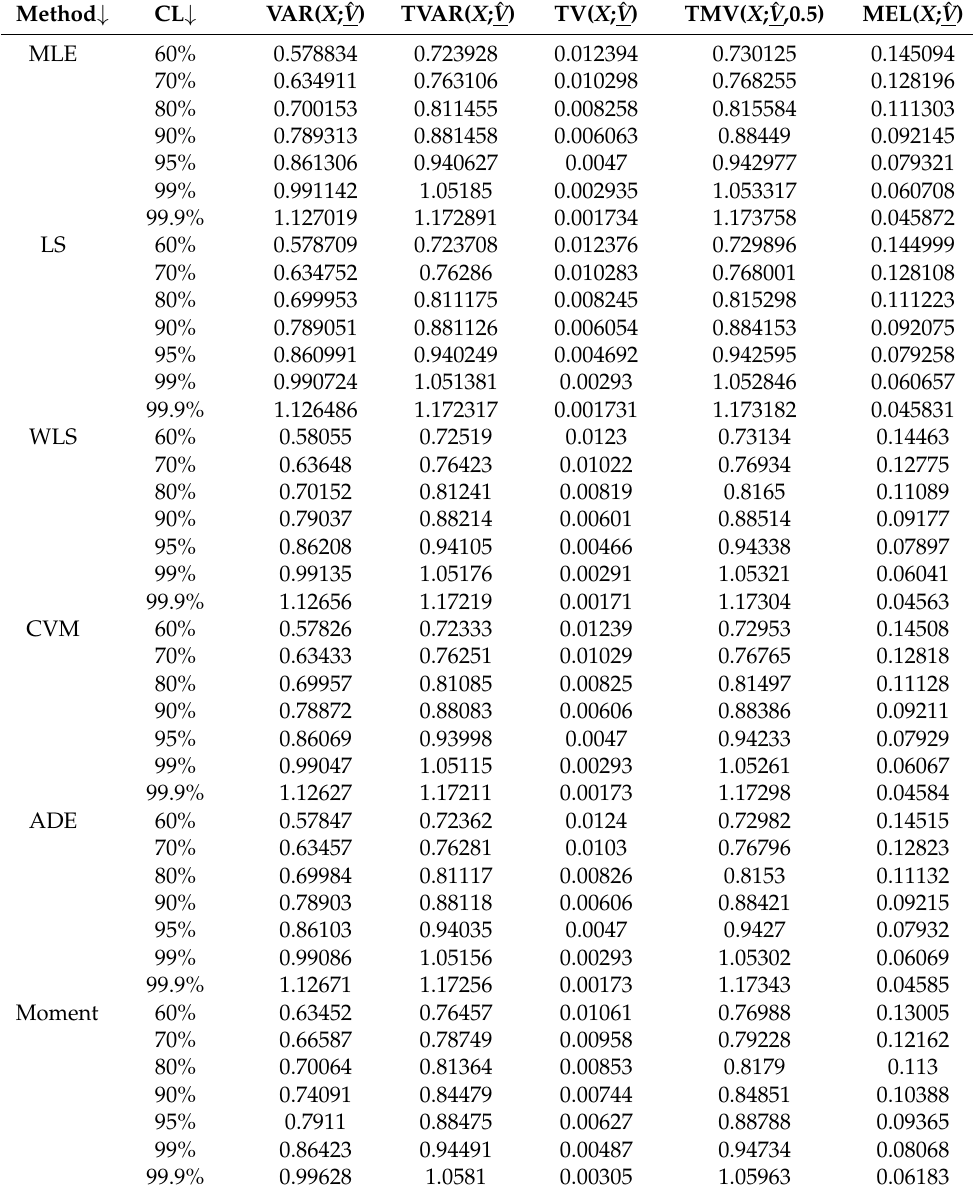
Table A4. The KRIs for the GRC under artificial data where n =